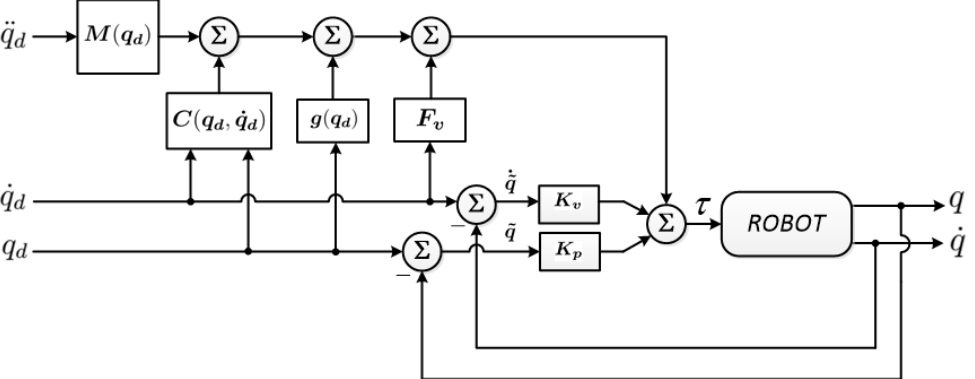
Figure 1. Proportional-Derivative (PD) Control plus Feedforward diagram. The feedforward block is formed by the dynamics of the robot evaluated at the desired angular positions, velocities, and accel-